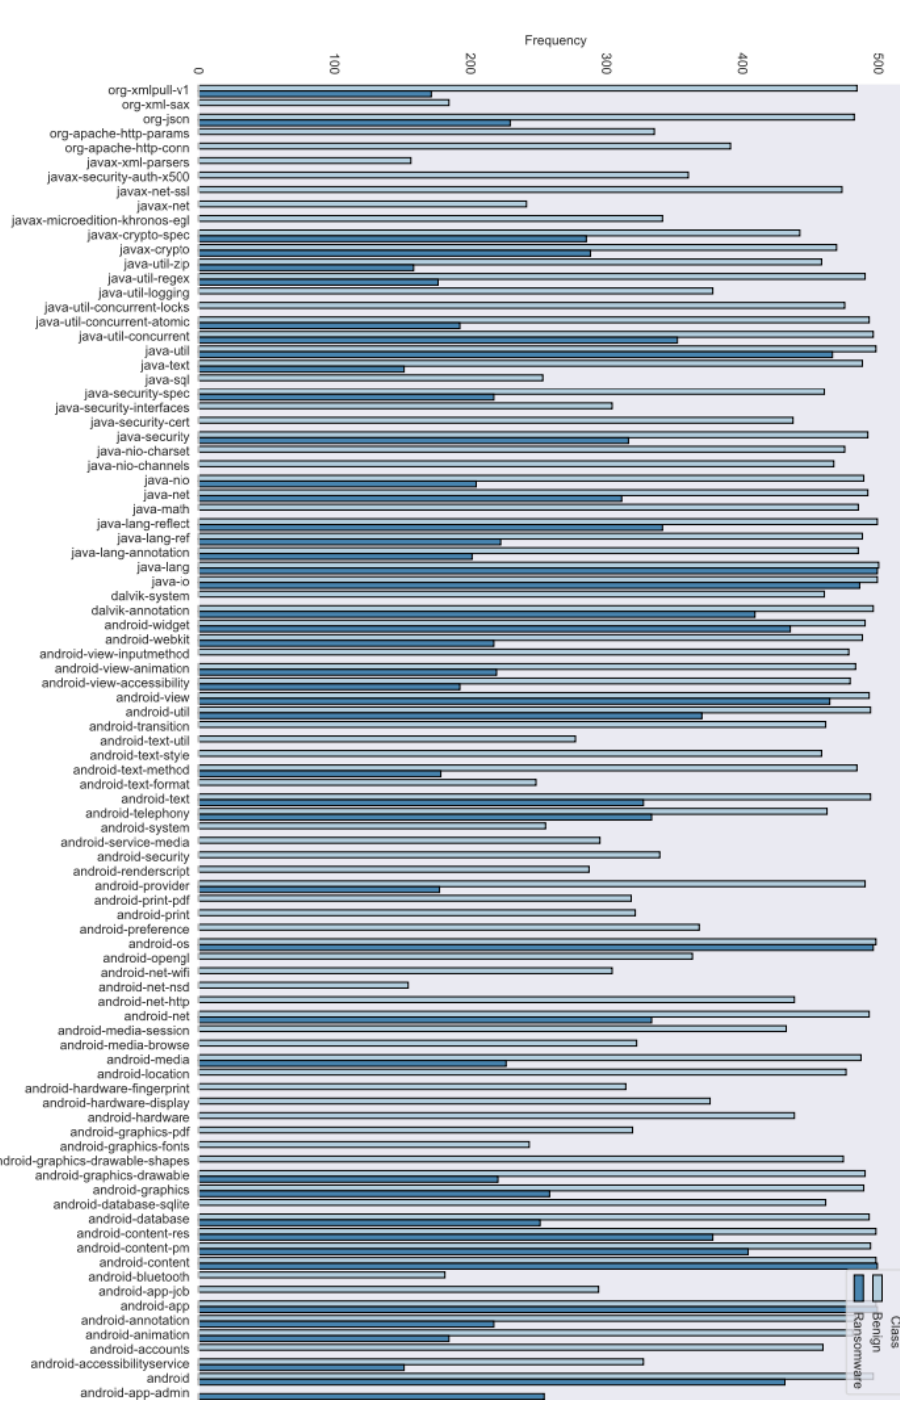
Figure 5. A bar chart shows the API features occurrences in the benign and ransomware classes. The features with less than 30% occurrences were